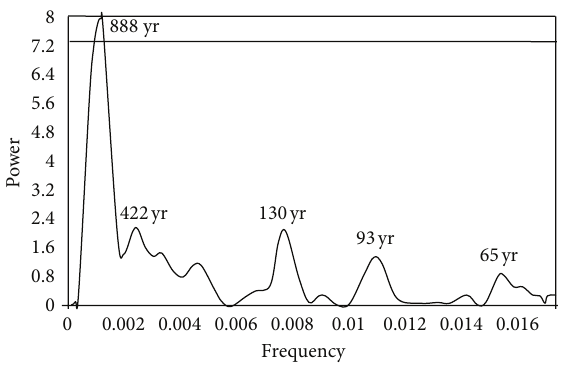
Figure 3: Spectral analysis of the magnetic susceptibility at the ambient temperature along the core from sebkha Mhabeul.